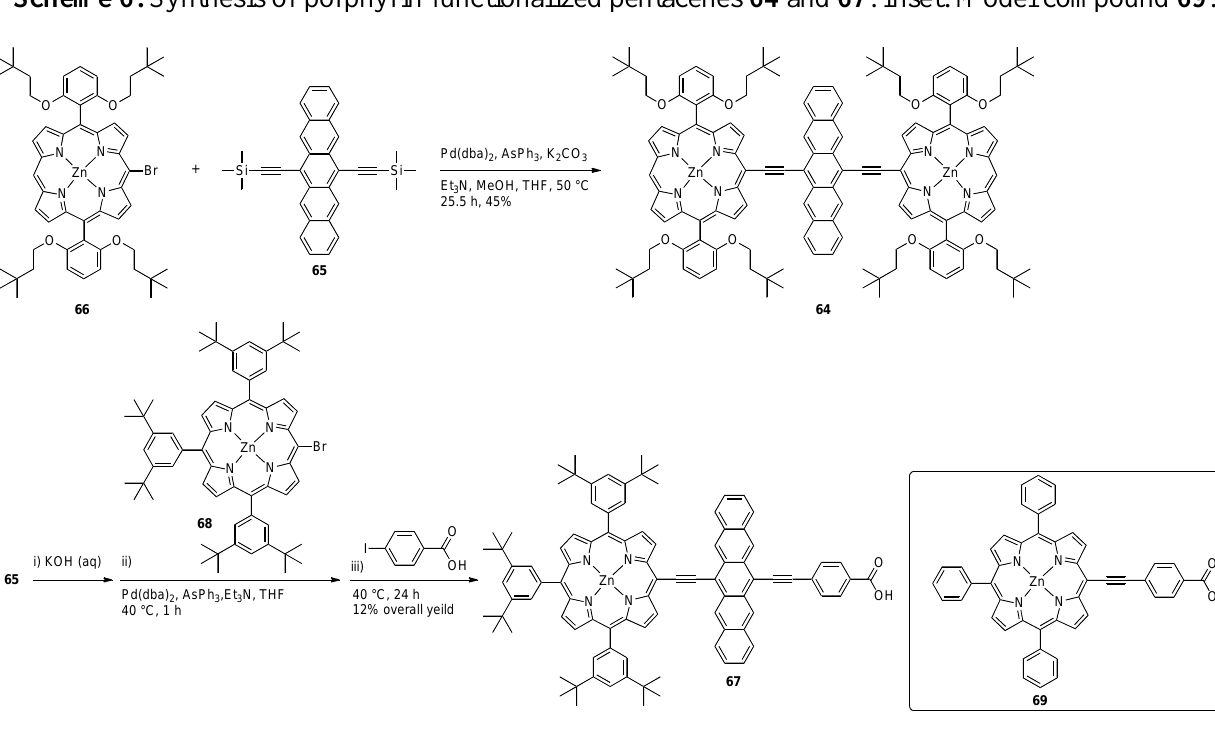
= E – E = ( E 1/2red + g LUMO HOMO